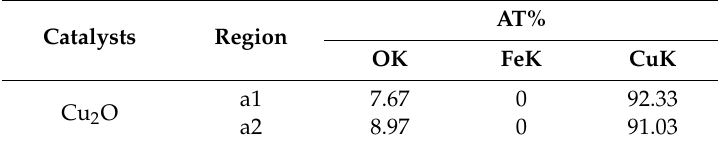
Table 1. EDS element analysis of di ff erent